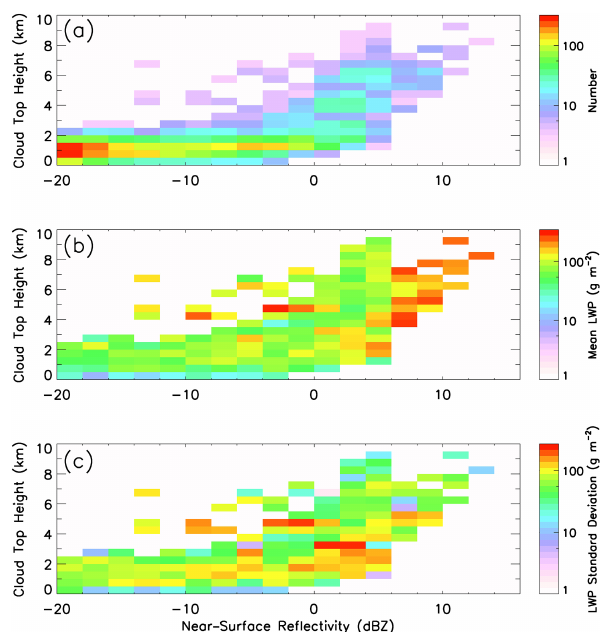
Figure 9. Scatterplot of glaciation ratio (see definition in the text) with (a) cloud top height, (b) surface snowfall rate, and (c) cloud temperature based on 5min averages of all observational data of snow clouds in the 2017–2018 winter.